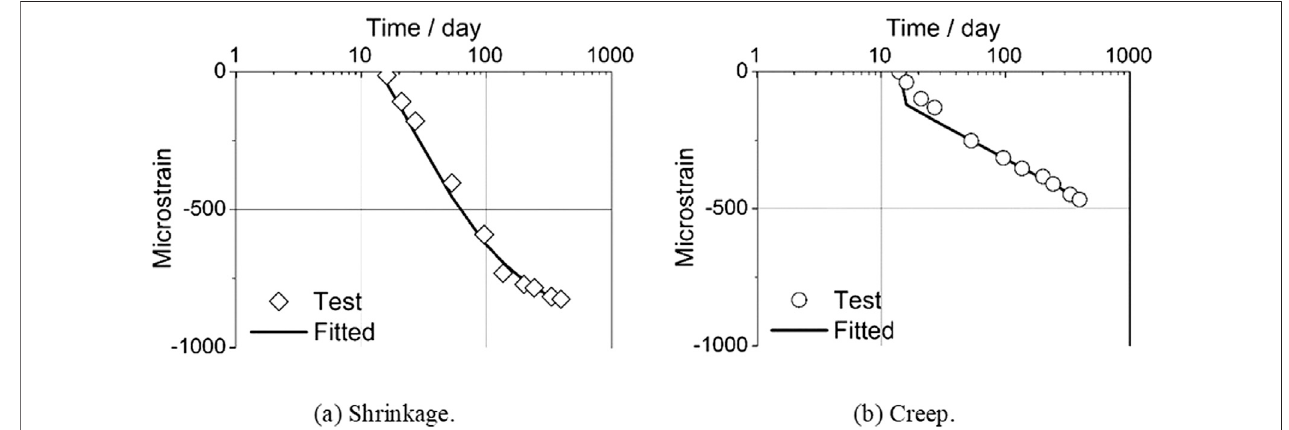
FIGURE 7 | Experimental data and numerical fi tting for concrete shrinkage and